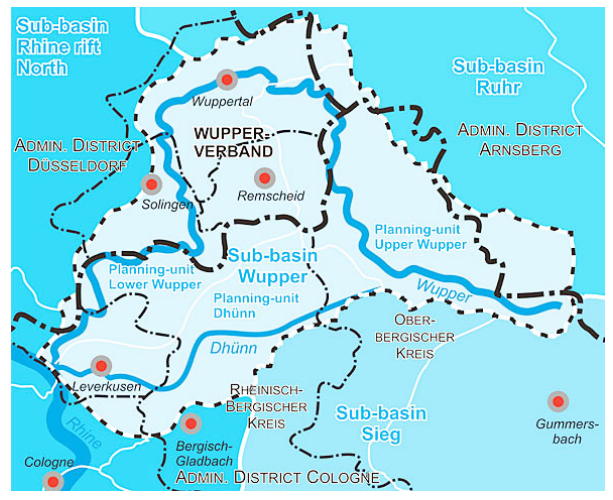
Fig. 1. Spatial misfits in the Wupper